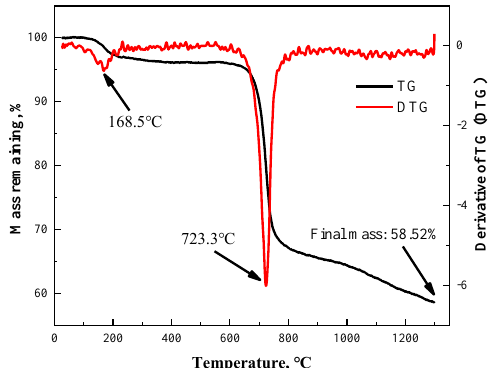
Figure 1. Thermalgravimetric analysis (TGA) results of poly(p-phenylene benzobisoxazole) PBO fiber heated up to 1300 °C under an inert atmosphere.